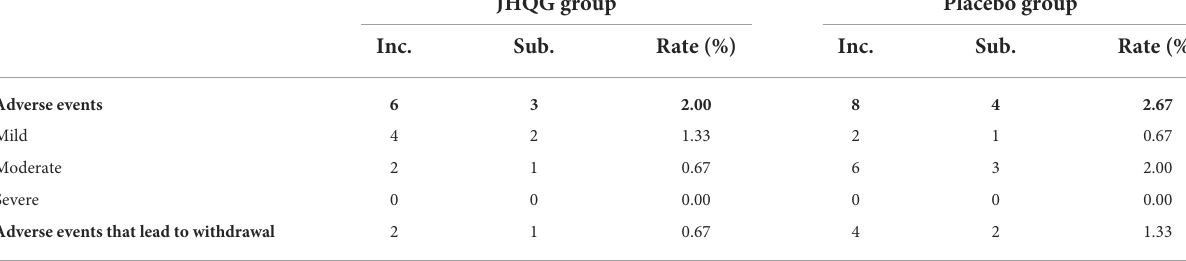
TABLE 8 Adverse events/reactions and their severity levels observed during the trial (SS). JHQG group Placebo group Inc. Sub. Rate (%) Inc. Sub.